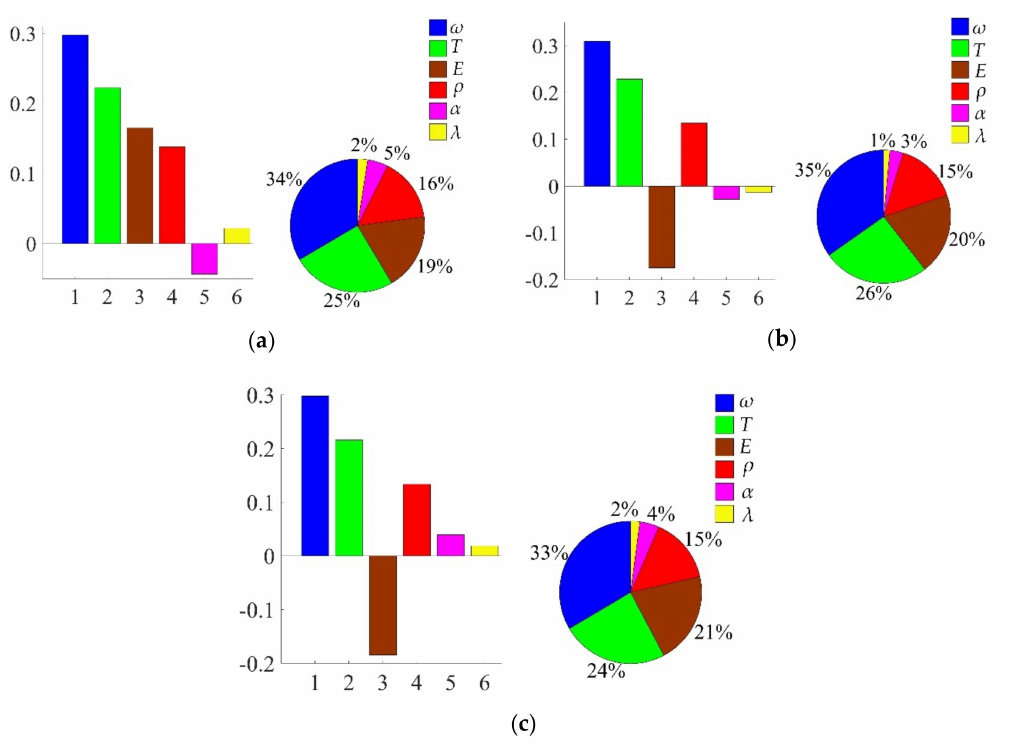
Figure 13. Sensitivities and e ff ect probabilities with di ff erent decomposed output responses: ( a ) mean